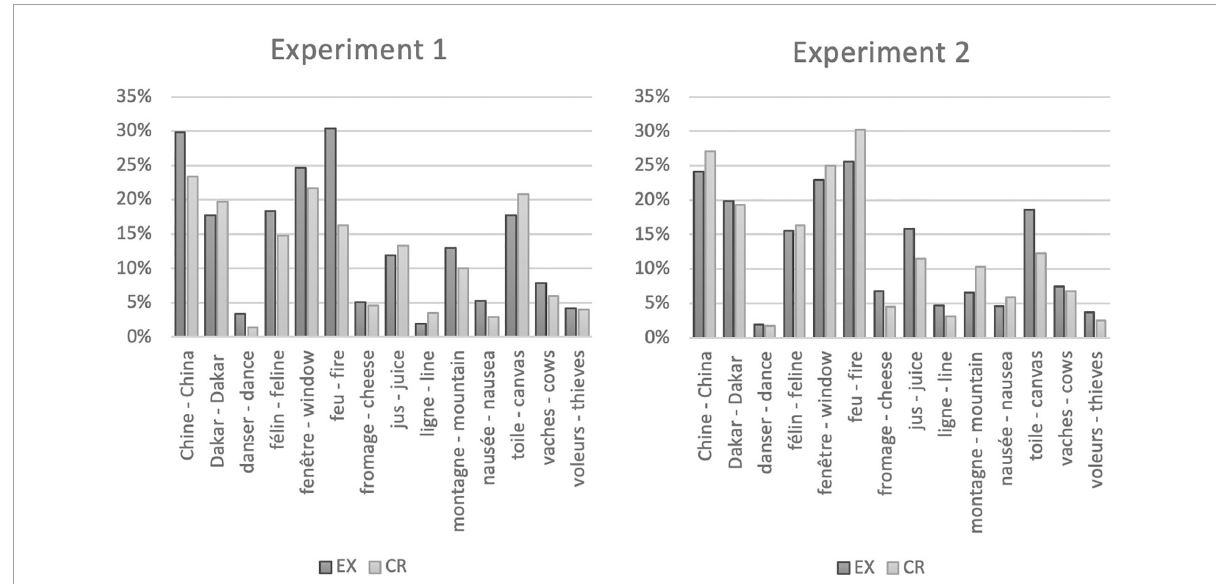
FIGURE5 Bar-plot for the %RR (percentual rebus resolution) upon target word presentation in the EX (experimental—white bars) and CR (control—black bars) conditions of Experiment 1 and of Experiment 2.